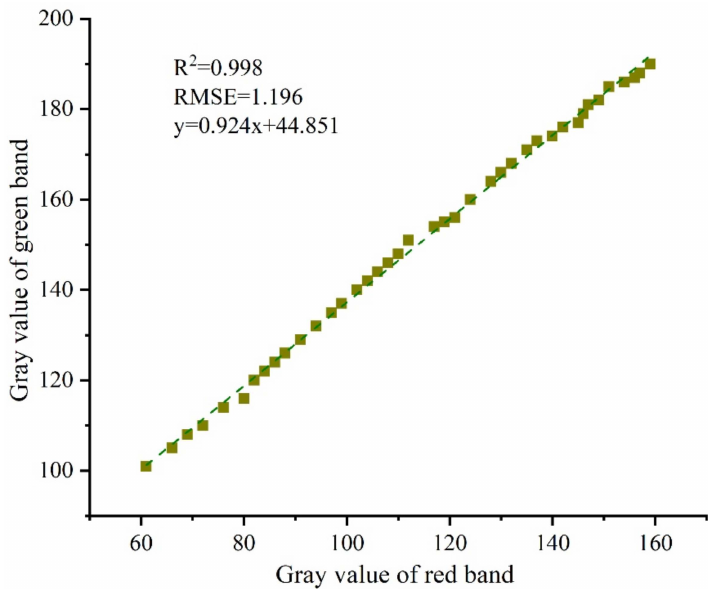
Figure 2. Fitting results of the green band and red band for potato plant